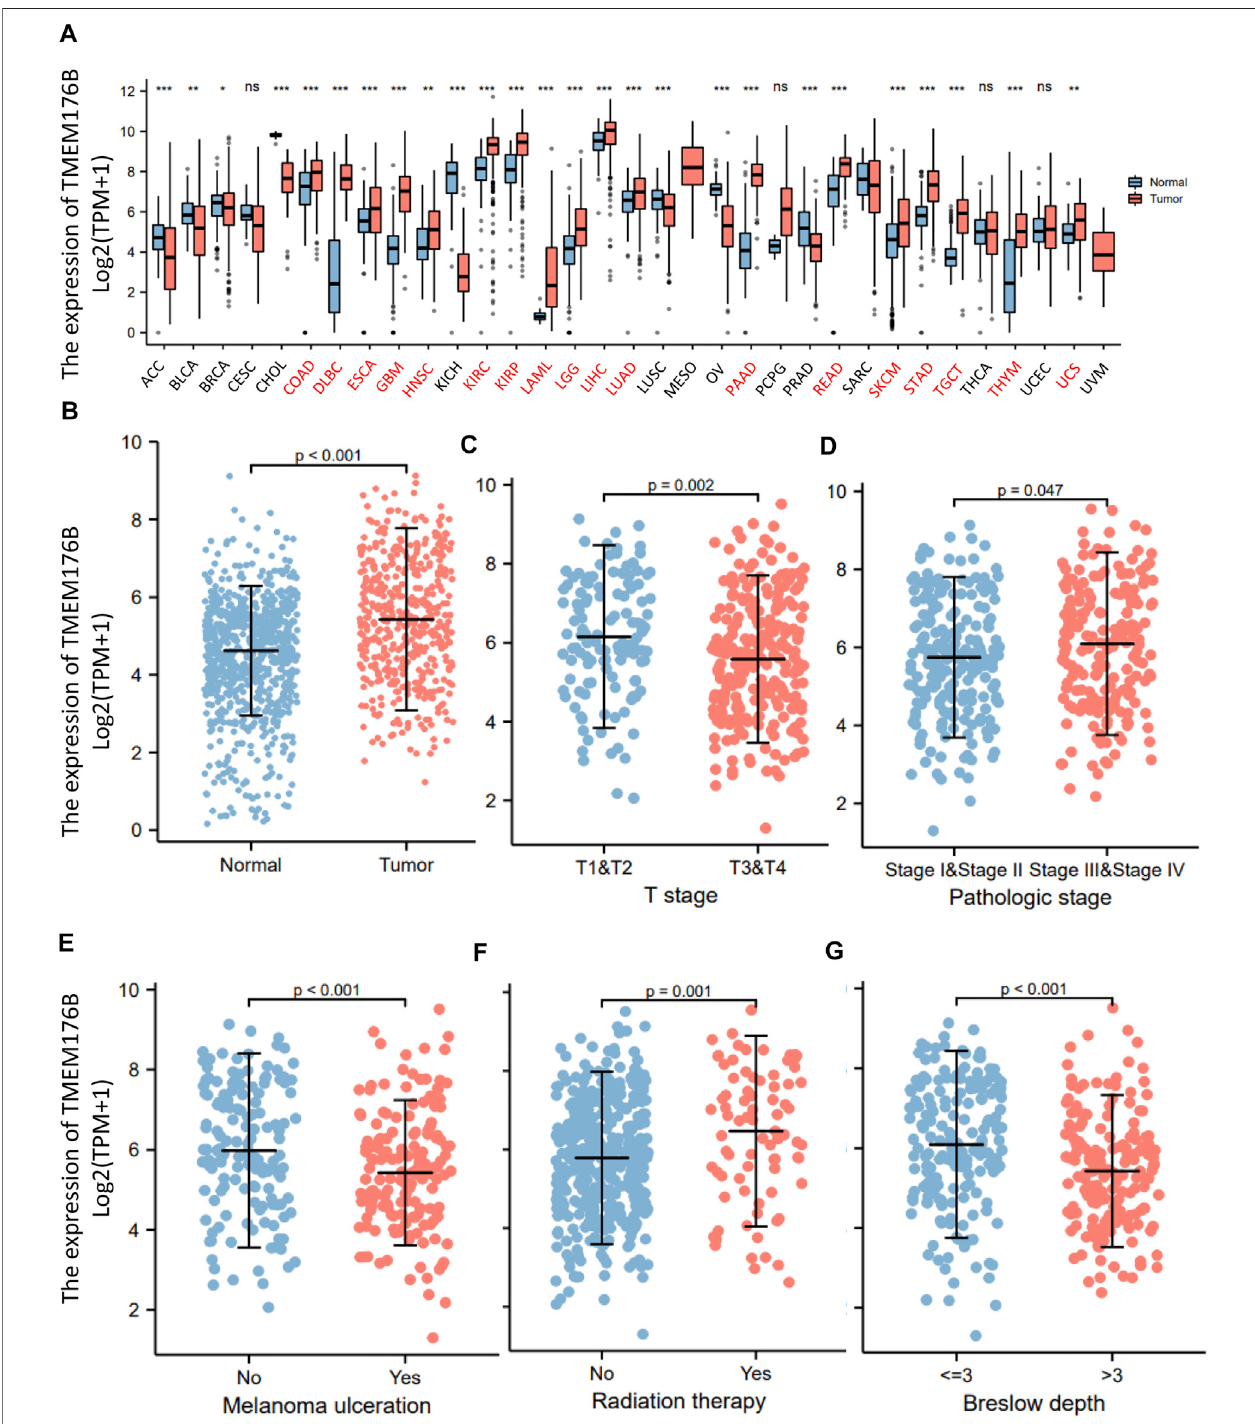
FIGURE1| Theexpression of TMEM176B in malignancies. (A) Theexpression status ofthe TMEM176B acrossvarious cancertypes. * p < 0.05; ** p < 0.01;*** p < 0.001. (B) The expression level of TMEM176B in SKCM was signi fi cantlyincreased compared tothe normal tissue( p < 0.001). (C – G) Associationbetween TMEM176B and several clinical features in SKCM.